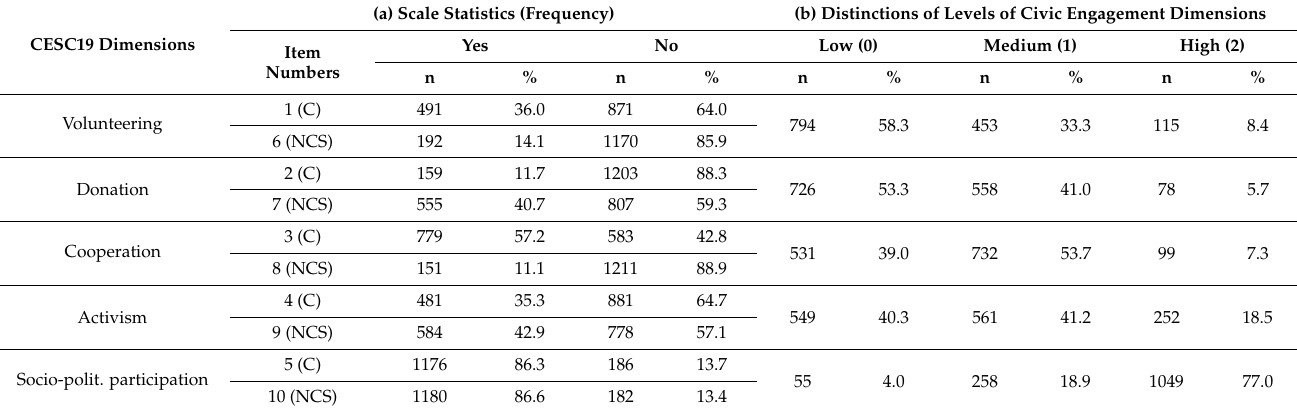
Table 2. Descriptive results of the study—the level of civic engagement during the COVID-19 outbreak in the experiences of Polish, Croatian, and Lithuanian students (n = 1362). (a) Raw results on the Civic Engagement Scale during COVID-19; frequency of “Yes” and “No” responses regarding the CESC19 scale’s items (item numbers in order of dimensions; for items’ content see measurement section). (b) Distinctions of the level of civic engagement derived from distributional information from the collected data, as follows: low (0) = lack of “yes” responses regarding any of the items from a specific CE dimension, medium (1) = one “yes” response regarding items from a specific CE dimension, high (2) = both “yes” responses regarding items from a specific CE